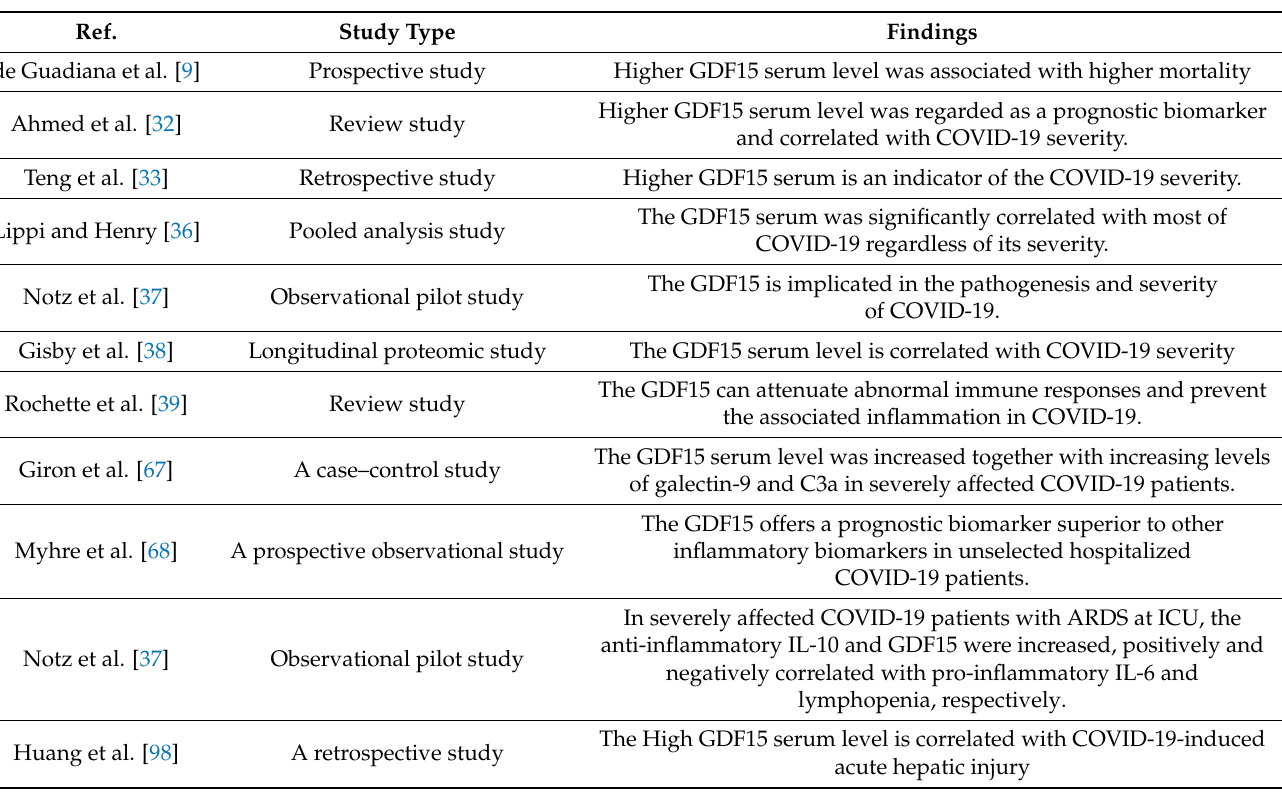
Table 1. The potential role of GDF15 in